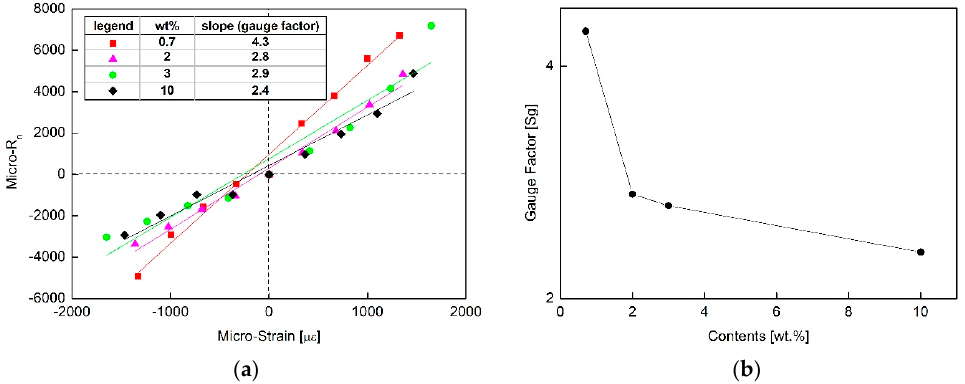
Figure 4. Piezoresistive characteristics of MWCNT/epoxy composites for strain sensors: ( a ) experimental strain model and ( b ) gauge factor w.r.t MWCNT wt. %.